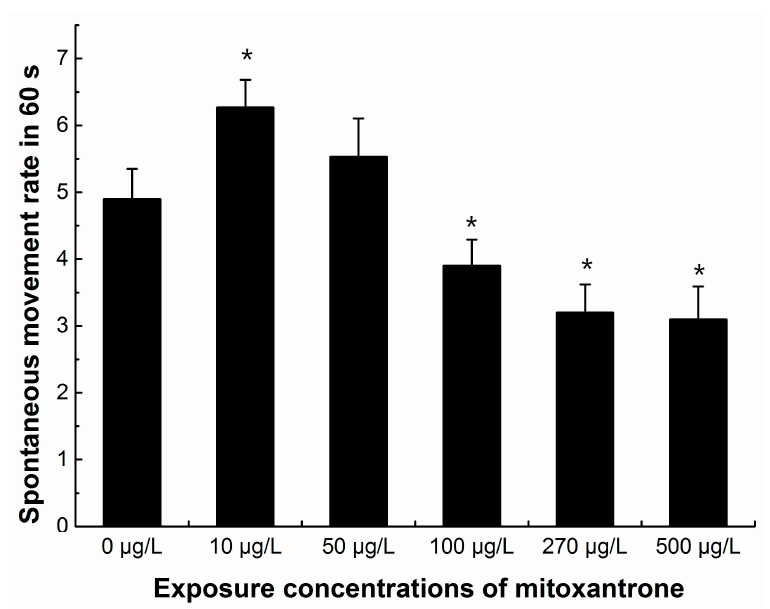
Figure 5. The numbers of spontaneous movement of zebrafish embryos (24 hpf) in 60 s. Eight embryos in each group were chosen for counted, and each group was conducted in six biological repeats ( n = 48 totally in each group). All values are expressed as means ± standard error of the mean (SEM). * represents significant difference compared to control, p < 0.05.